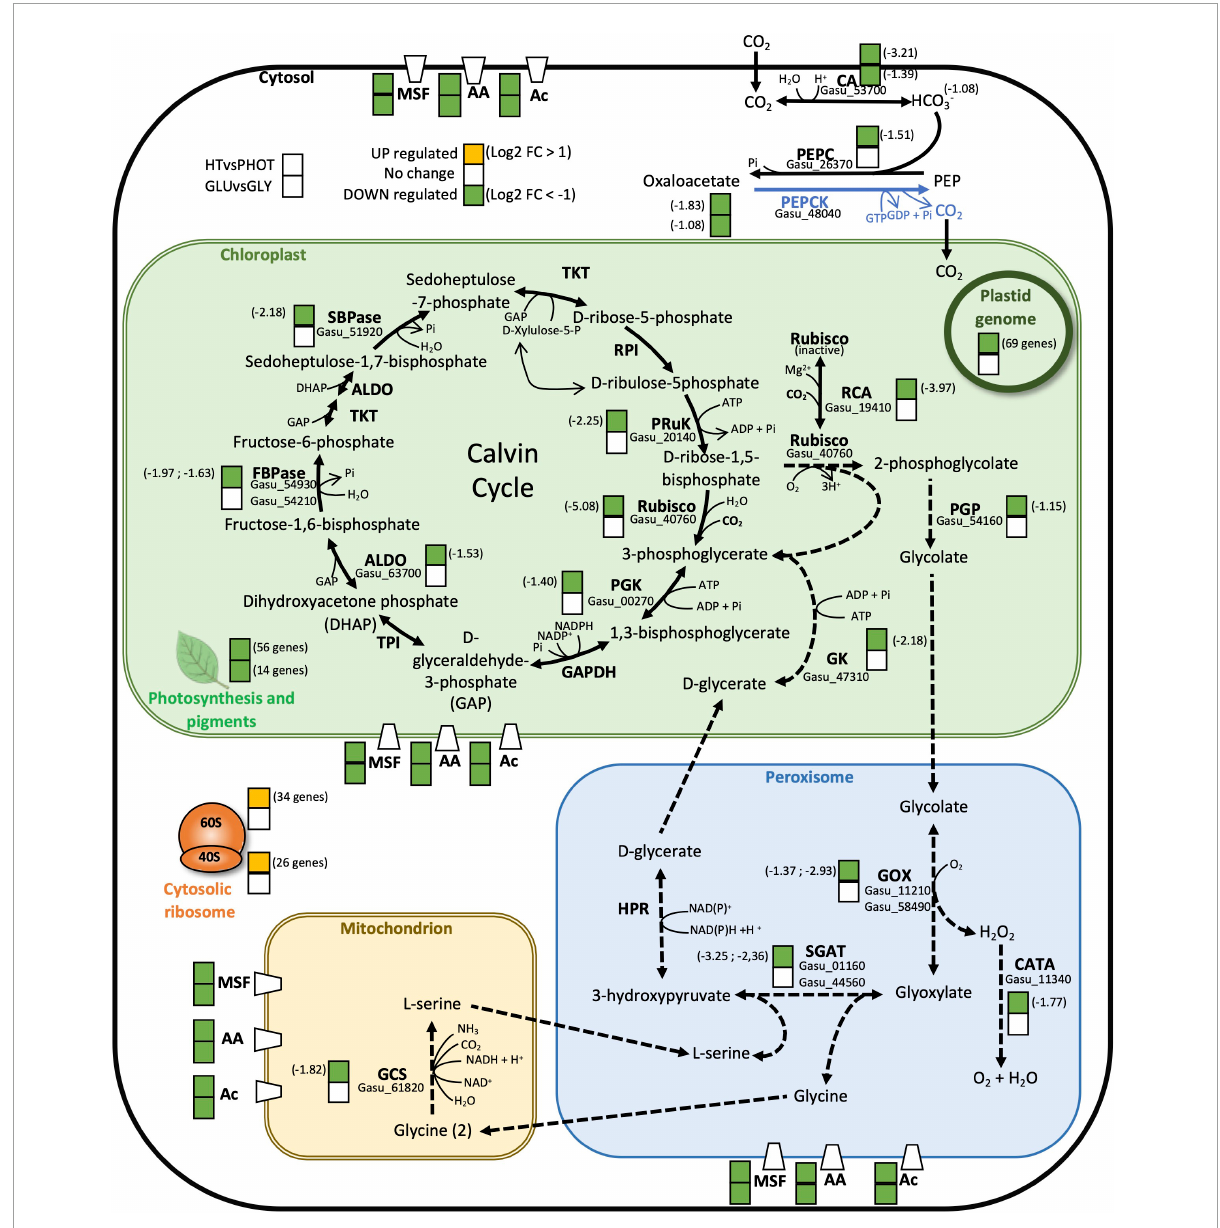
FIGURE7 Schematic representation of the carbon concentrating (CCM) and photorespiration pathways (solid and dashed arrows, respectively). Cytosol is in white, chloroplast is in green, peroxisome is in blue, mitochondrion is in light brown, plastid genome in dark green, and ribosome is in orange. Leaf drawing shows the number of genes that are differentially expressed in photosynthesis related enzymes and pigment biosynthesis. Enzymes are highlighted and intermediated metabolites are shown in normal letters. Enzymes encoded by differentially expressed genes are marked with two overlapped squares. The one on the bottom refers to glucose compared to glycerol differentially expressed genes and the one on the top refers to heterotrophy compared to phototrophy differentially expressed genes. Green color is for downregulated genes, yellow color for overexpressed genes, and white color means no significant differences in gene expression. Log2FoldChange is written on the right or on the left size of the squares when differences are observed. Gene names are written above enzymes abbreviation. Blue arrow shows the limiting step of gluconeogenesis liberating carbon dioxide. Abbreviations for enzymes: ALDO, aldolase (fructose-bisphosphate aldolase); FBPase, fructose-1,6-bisphosphatase; GAPDH, glyceraldehyde-3-phosphate dehydrogenase; PGK, phospho-glycerate kinase; PRuK, phosphoribulokinase; RPE, ribulosephosphate 3-epimerase; RPI, ribose 5-phosphate isomerase; Rubisco, ribulose-1,5-bisphosphate carboxylase/oxygenase; SBPase, sedoheptulose-1,7-bisphosphatase; TKT, transketolase; TPI, triose-phosphate isomerase; PGP, phosphoglycolate phosphatase; CA, carbonic anhydrase; PEPC, phosphoenolpyruvate carboxylase; PEPCK, phosphoenolpyruvate carboxykinase; CATA, catalase; GOX, glycolate oxidase; SGAT, serine/glyoxylate transaminase; HPR, hydroxypyruvate reductase; GK, glycerate kinase; GCS, glycine cleavage system; RCA, rubisco activase. Transporter proteins are marked with white trapezes crossing the membranes and their abbreviations are: MSF, major facilitator superfamily; AA, amino acid transporters; Ac, acetate